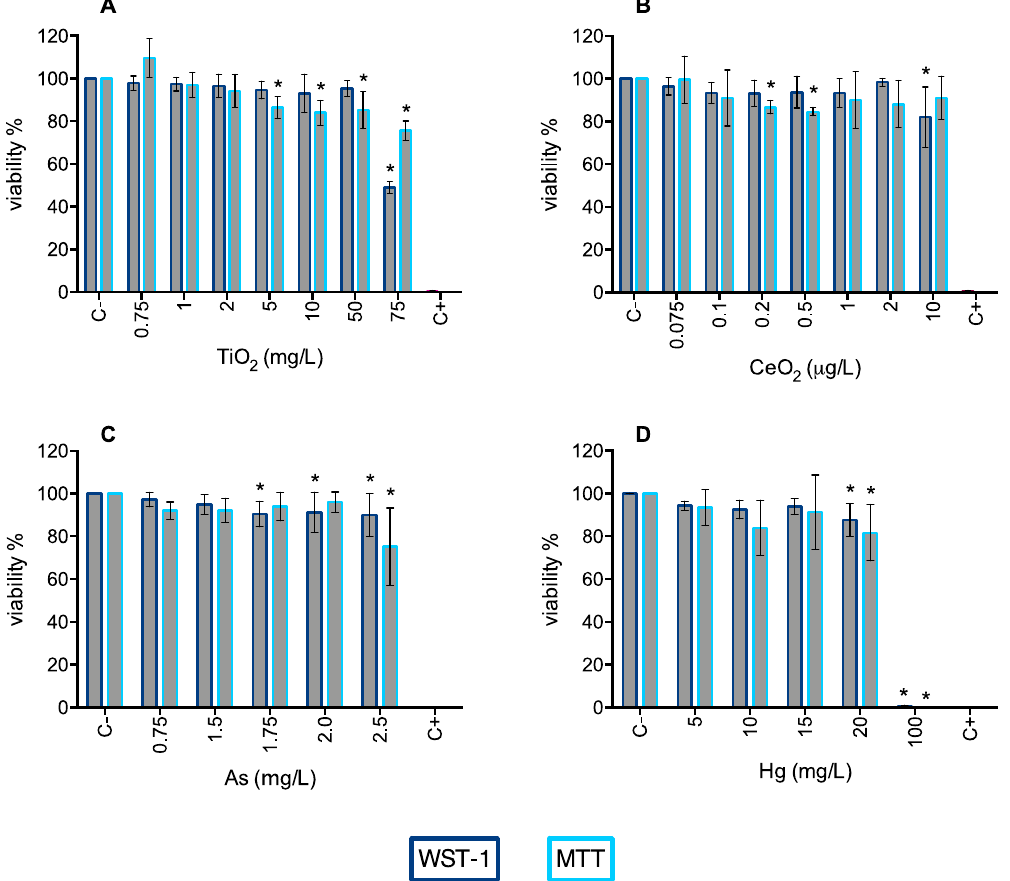
Figure 7. Viability of A549 cells 24 h post ‐ exposure to TiO 2 NP ( A ), CeO 2 NP ( B ), As ( C ), and Hg ( D ) assessed by WST ‐ 1 (dark blue bars) and MTT (light blue bars) assays. C − negative control; C+: positive control (Triton X ‐ 100 1%). Values are expressed as mean ± standard deviation (n = 4, each experiment in triplicate). Statistical significance of samples compared to C − is indicated by * (One ‐ way ANOVA).